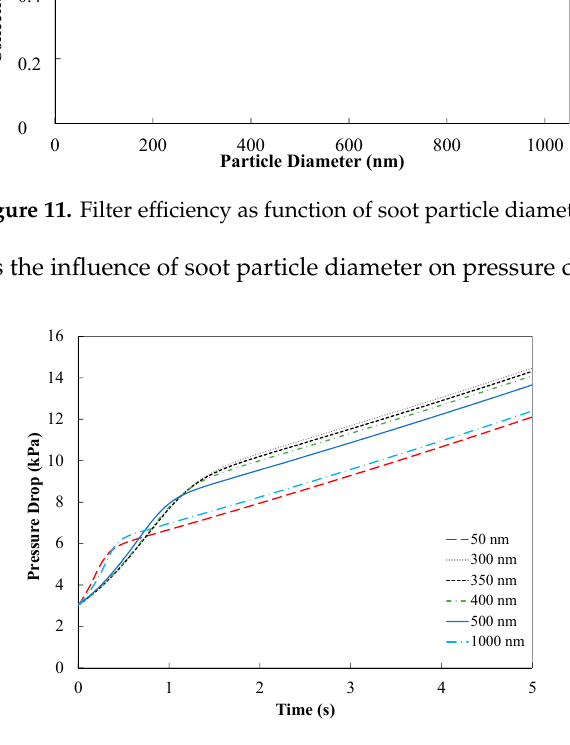
Figure 12. Pressure drop evolution with time during loading stage as function of particle diameter.